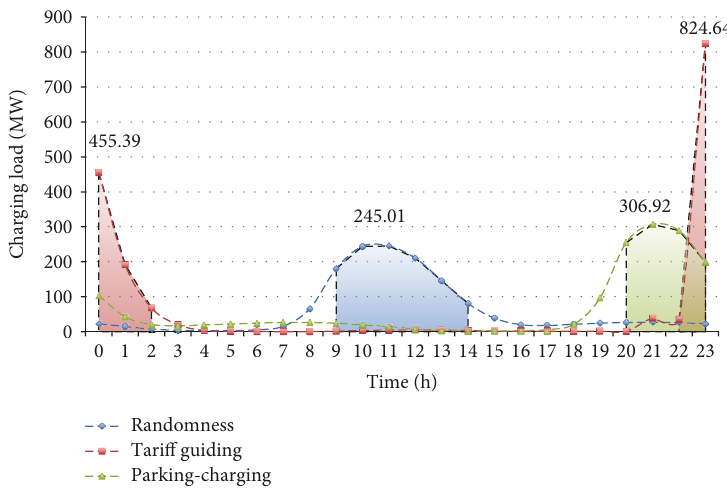
Figure 7: The hourly charging loads under 3 di ff erent